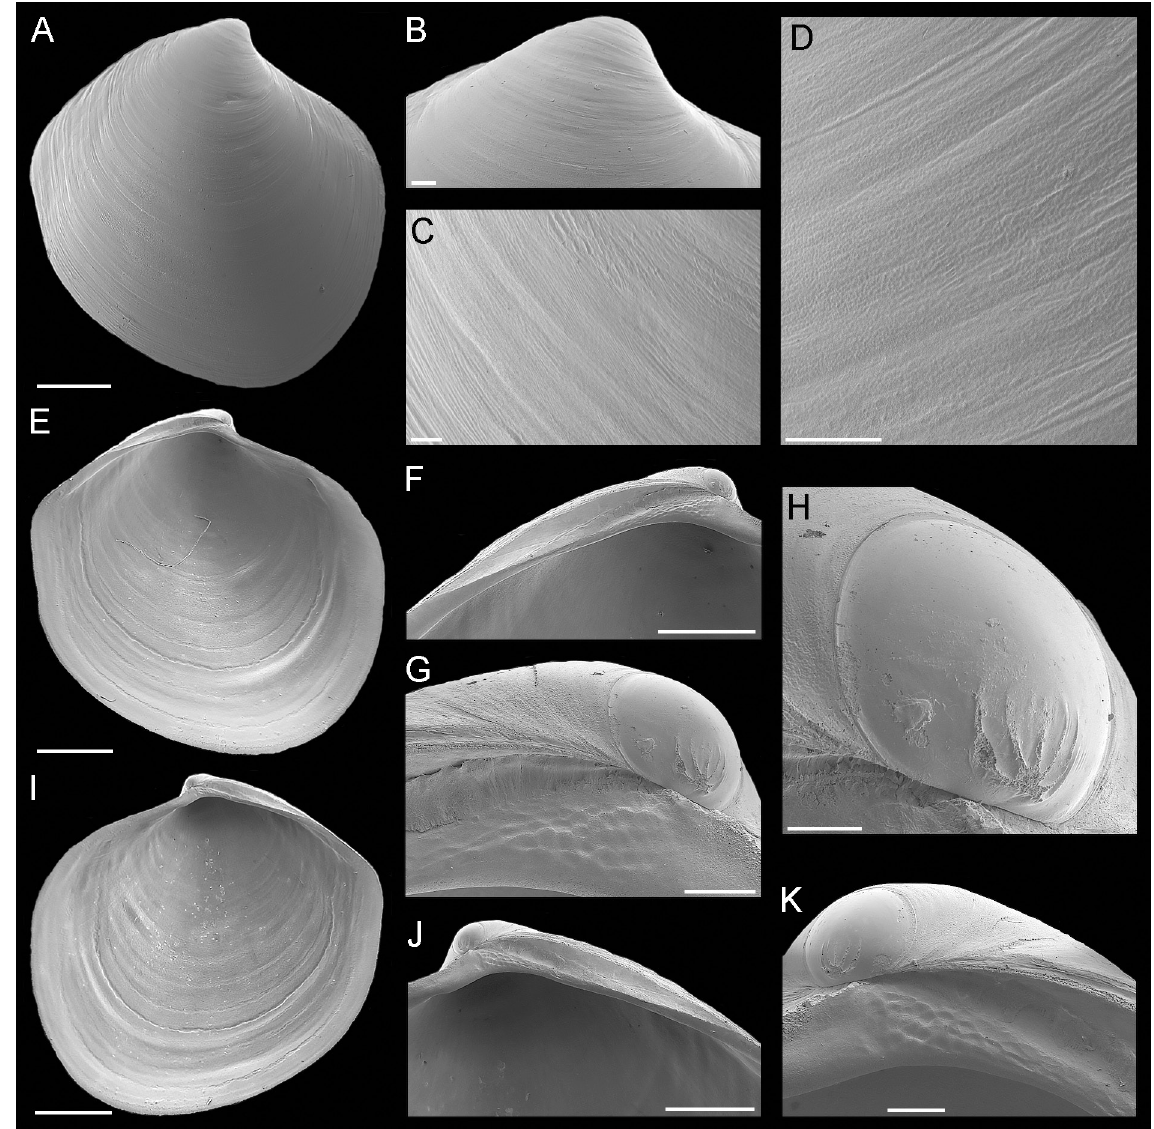
Fig 3. Scanning electron micrographs of Parathyasira coani sp. nov. (MIMB 43819). A . Exterior view of right valve. B . Sculpture of beak region. C–D . Sculpture of central shell part. E . Interior view of left valve. F . Hinge plate of left valve. G . Pits under beak of left valve. H . Prodissoconch. I . Interior view of right valve. J . Hinge plate of right valve. K . Pits under beak of right valve. Scale bars: A, E, I = 1 mm; F, J = 500 µm; B–D, G, K = 100 µm; H = 50